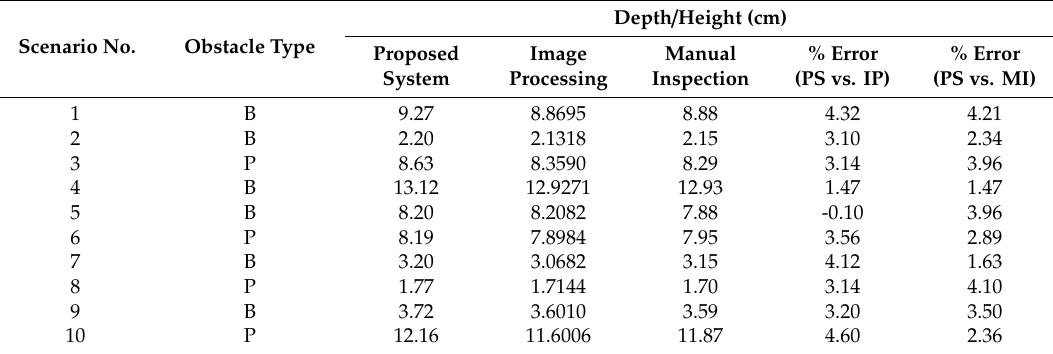
Table 12. Comparison of depth / height between the proposed system (PS), image processing (IP), and manual inspection (MI) for the R2 test